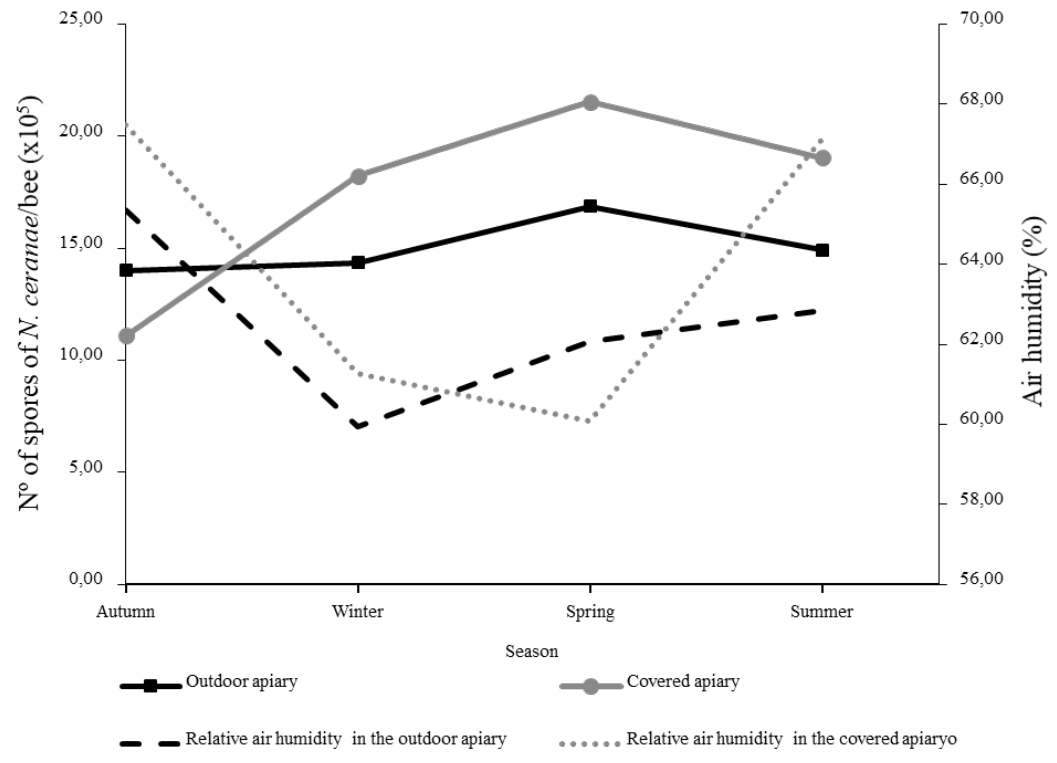
Fig 3 . Intensity of natural infection of Nosema ceranae (mean number of spores/bee x10 5 ) and relative air humidity in hives located in open air apiary and covered apiary from August 2013 to August 2016 in relation to